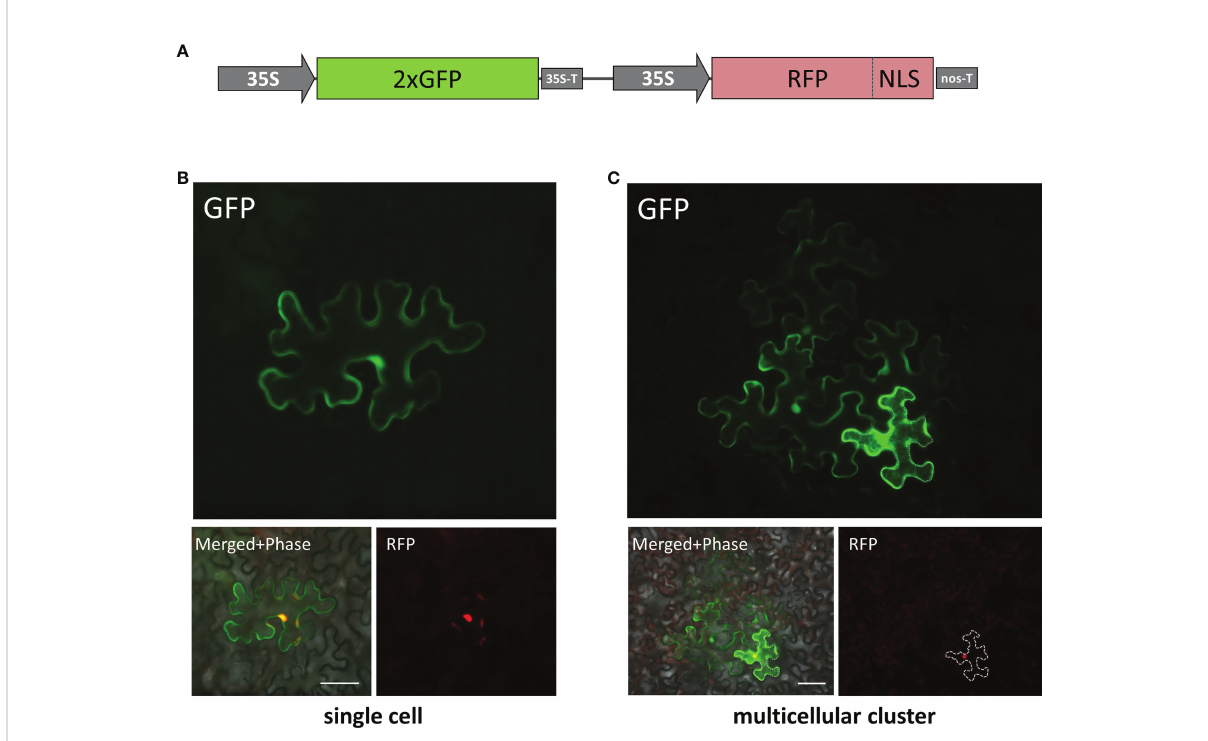
FIGURE 5 Visualization of 35S-2×GFP//35S-RFP:NLS expression and 2×GFP intercellular movement in epidermal cells of N. benthamiana leaves. (A) Schematic representation of 35S-2×GFP//35S-RFP:NLS construct containing two expression cassettes. Single cell (B) and multicellular cluster (C) in leaves agroin fi ltrated with 2×GFP//35S-RFP:NLS supplemented with “ empty vector ” pBIN (B) or with 35S-KPILP (C) . The primary infected cell nucleus is indicated by the fl uorescent signal from RFP and this cell outline is marked with a dashed line. Scale bar, 50